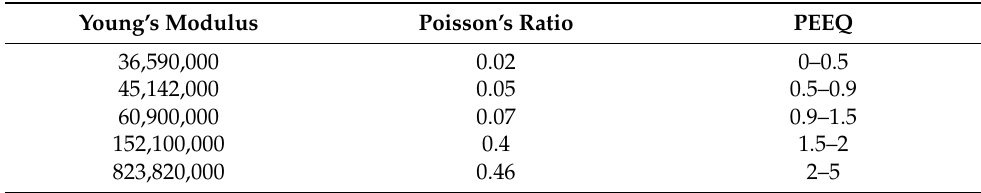
Table 1. Input data of the simulation using the MC model.